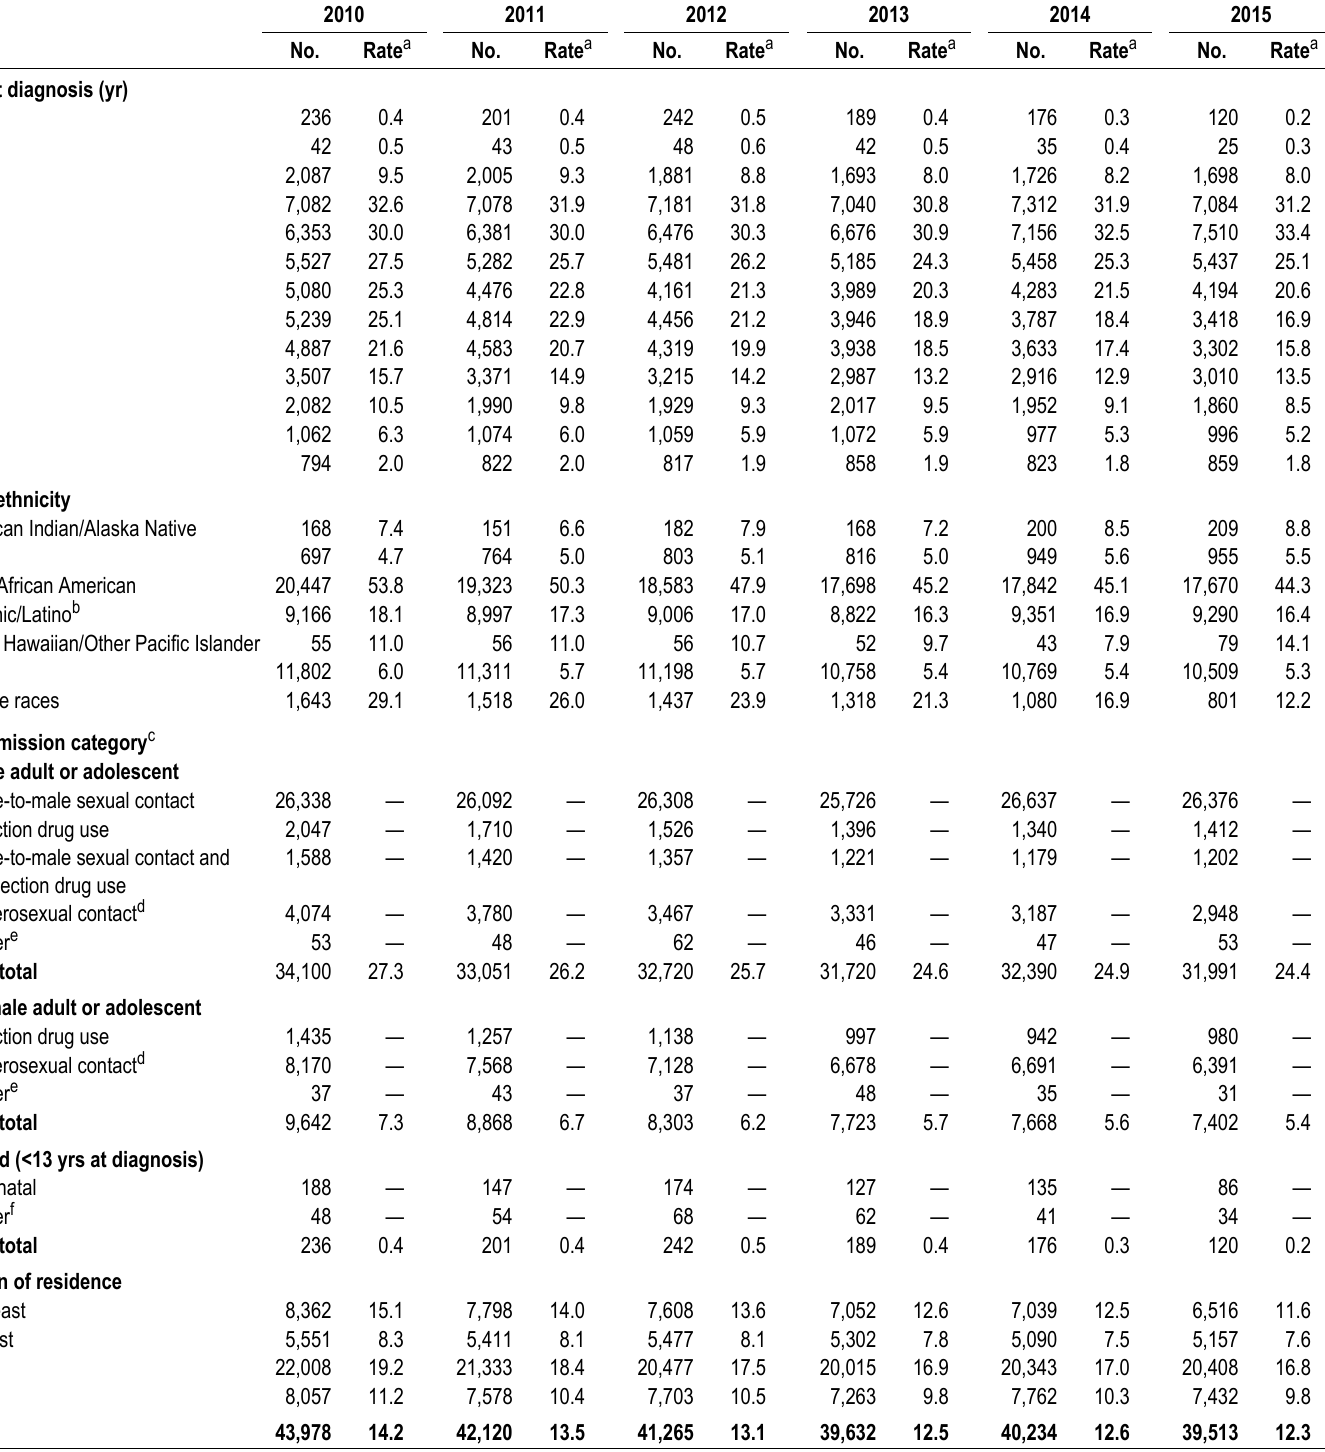
Table 1a. Diagnoses of HIV infection, by year of diagnosis and selected characteristics, 2010–2015—United